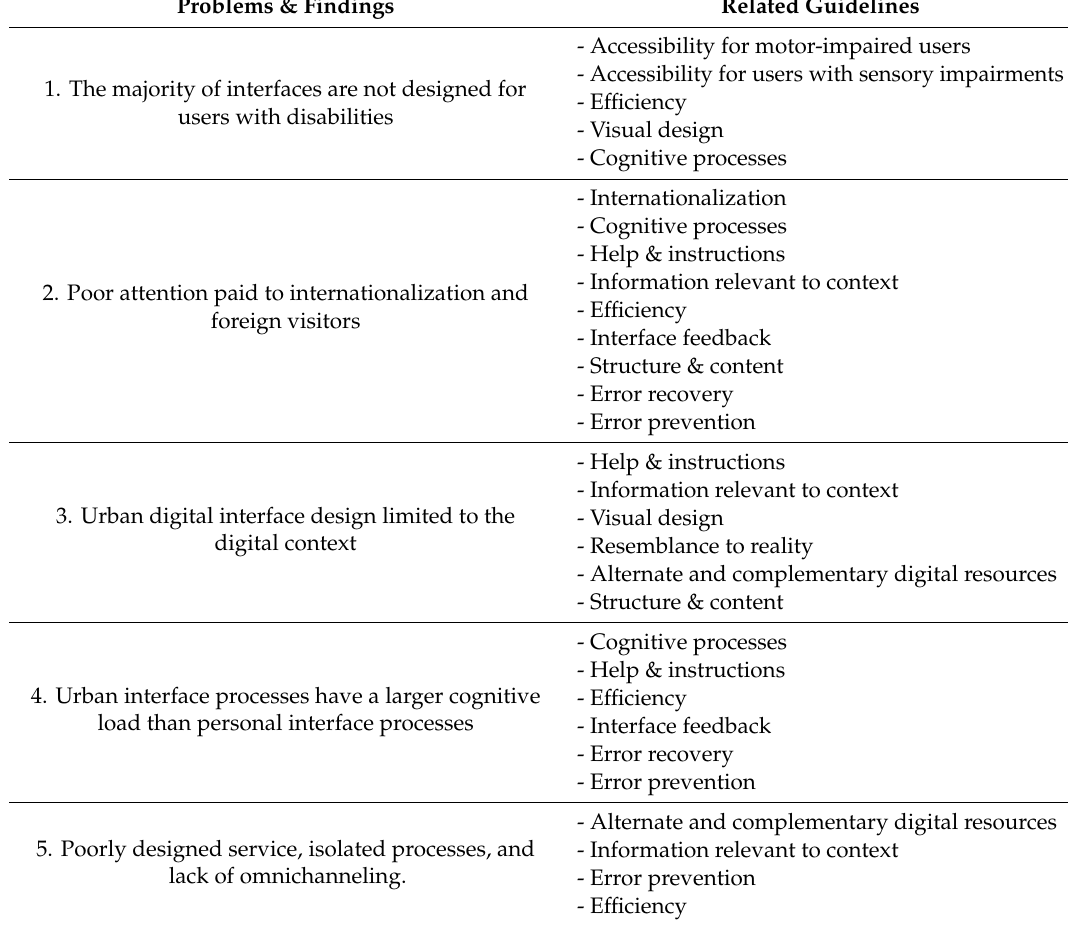
Figure 18. Customer experience map on automated parking machines in Cali. Touchpoints (in green) and the emotional journey can be observed. Table 6. Summary of problems and findings obtained and related guidelines.